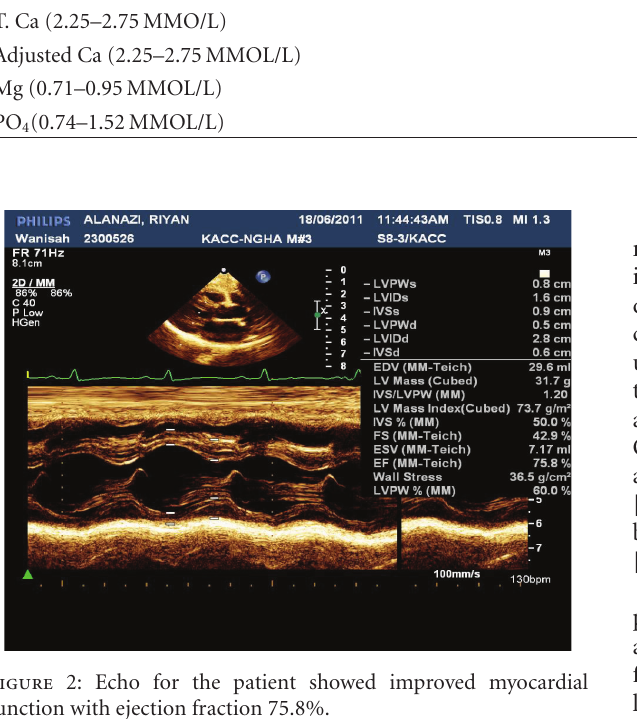
serum calcium. Vitamin D deficiency is the main cause of hypocalcemia in infants and old children. Nutritional rickets is still prevalent with the primary etiology being vitamin D deficiency in the breastfed infants and children [1,